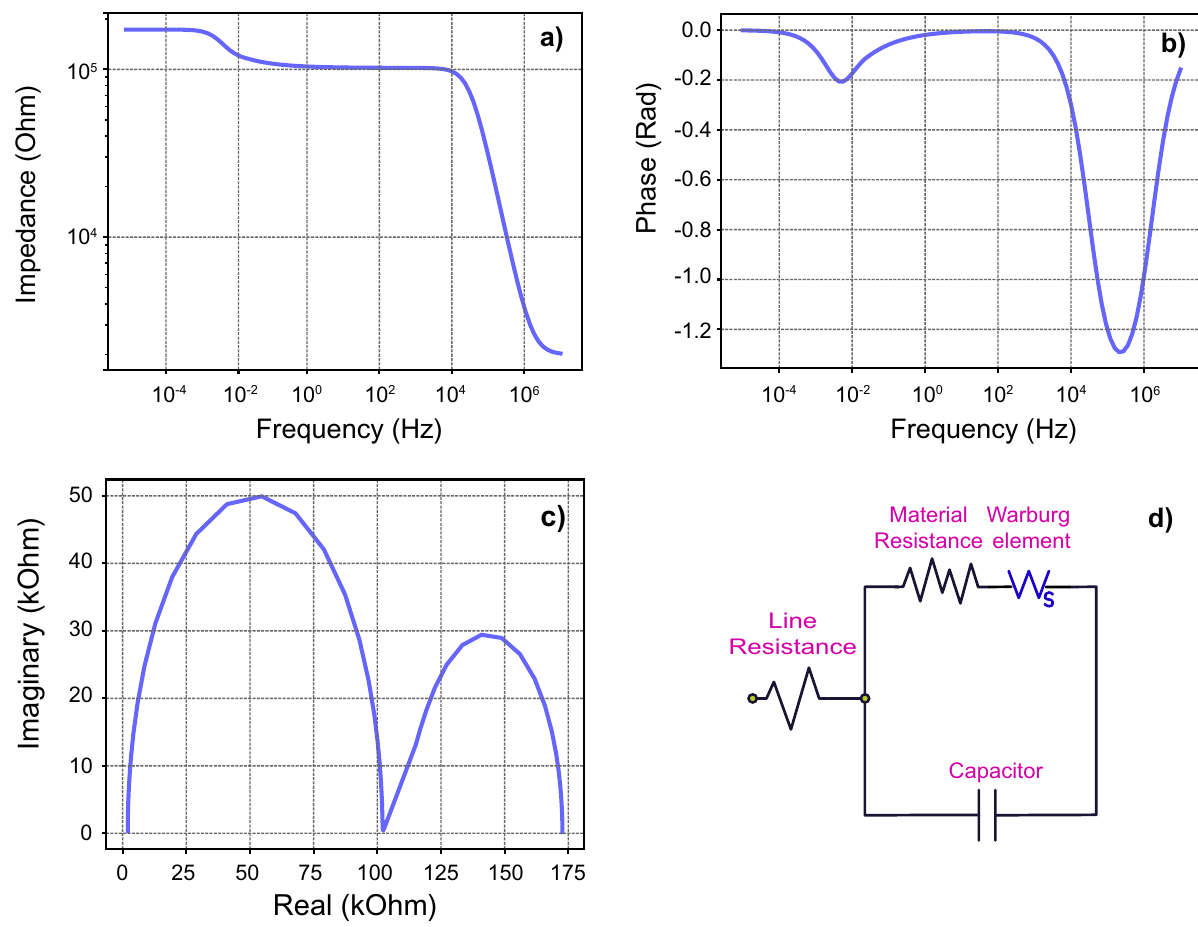
Figure 8. Subfigures ( a , b ) represent Bode plots, while, subfigure ( c ) presents the Nyquist plot of a device with an equivalent model which includes a Warburg diffusion element. The equivalent circuit used to simulate the attached plots is presented in subfigure ( d ) and is widely known in electrochemistry as a Randles cell. Data generated with EIS Spectrum Analyzer software 44